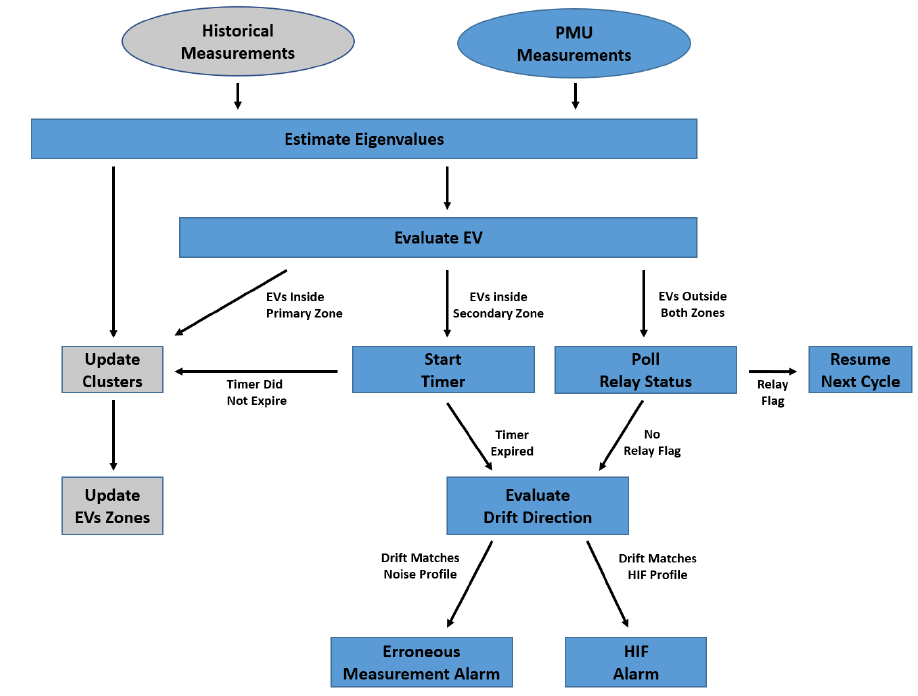
Figure 12. Flowchart illustrating the eigenvalue space analysis model.